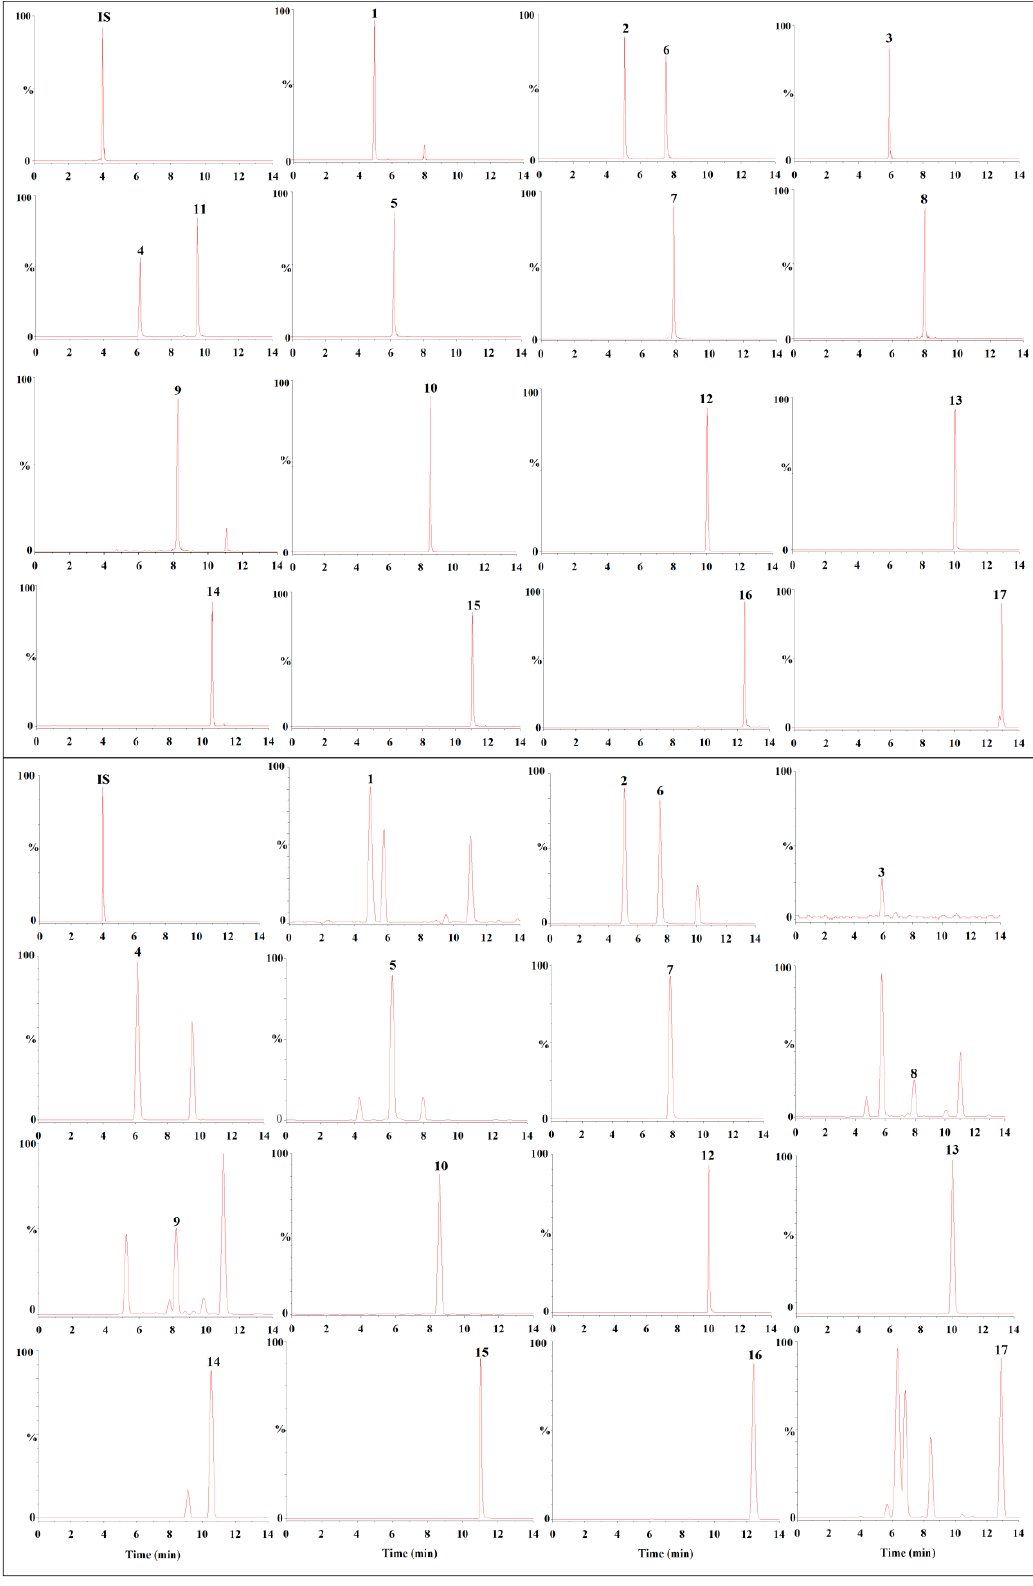
Figure 2. Ultra-high performance liquid chromatography (UHPLC)-MS/MS multiple reaction mode chromatograms of mixed standards (upper) and sample (lower, S9).